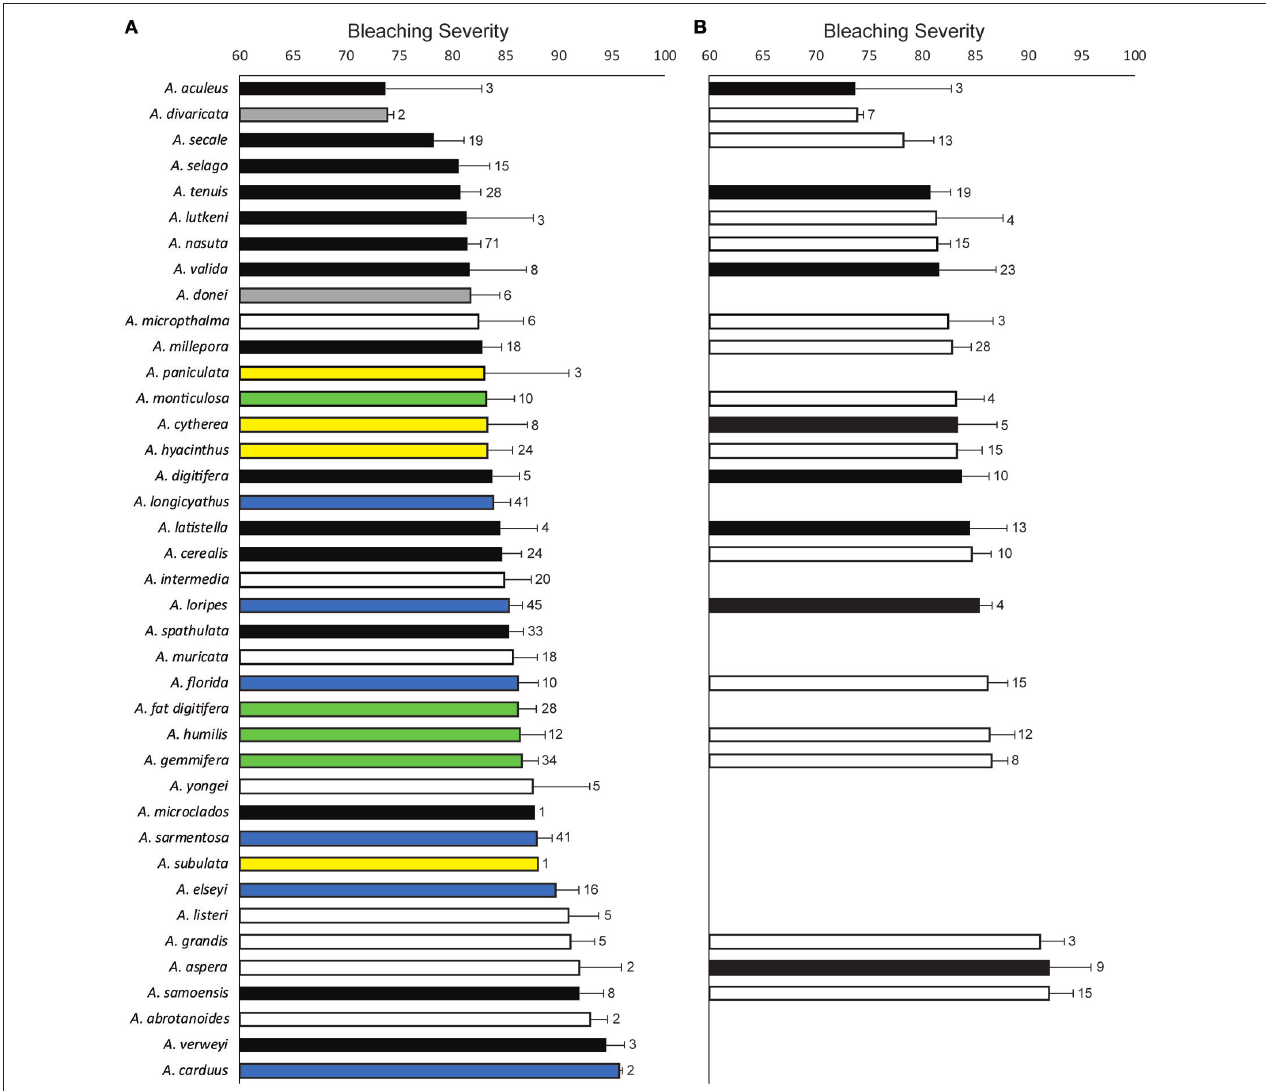
FIGURE 4 | Variation in bleaching severity within- and between-species in the genus Acropora observed at sites around Lizard Island in March 2016. Bars show the mean bleaching severity (colony “whiteness”) measured from white-balanced images of colonies of each species. Error bars show standard error and numbers adjacent to error bars indicate sample sizes. In (A) bars are colored by colony morphology as: black (corymbose), gray (arborescent table), white (arborescent), yellow (table), blue (hispidose), and green (digitate) and numbers indicate colonies observed in the field. In (B) bars are colored by symbiont association as: black (species has been recorded to associate with multiple symbiont types) and white (species has been recorded to only associate with a single symbiont type) and numbers indicate records of Symbiodinium type in the Geosymbio